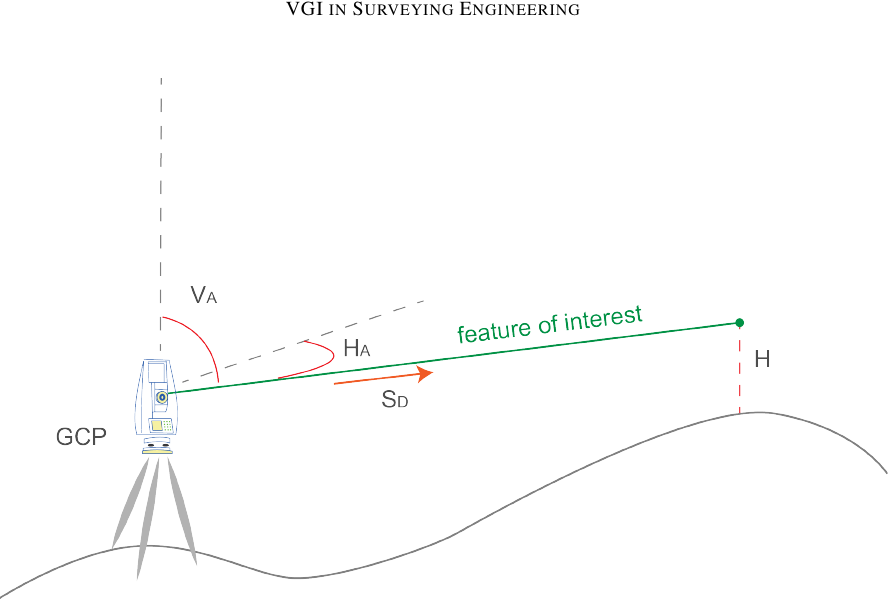
Figure 3: Illustration of observable quantities using total station